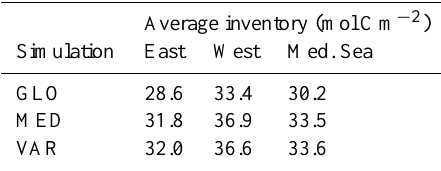
Table 4. Average δC T inventories in the eastern and western basins and for the entire Mediterranean